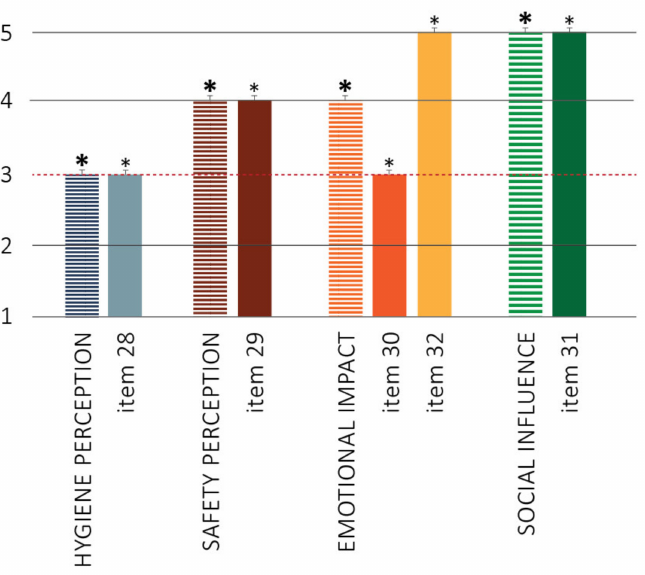
Figure 6. Temperature-measurement instruments: median values of the scores given by the users, differentiated per dimension and item. * dimension, p < 0.05; * item, p < 0.05. Own processing.